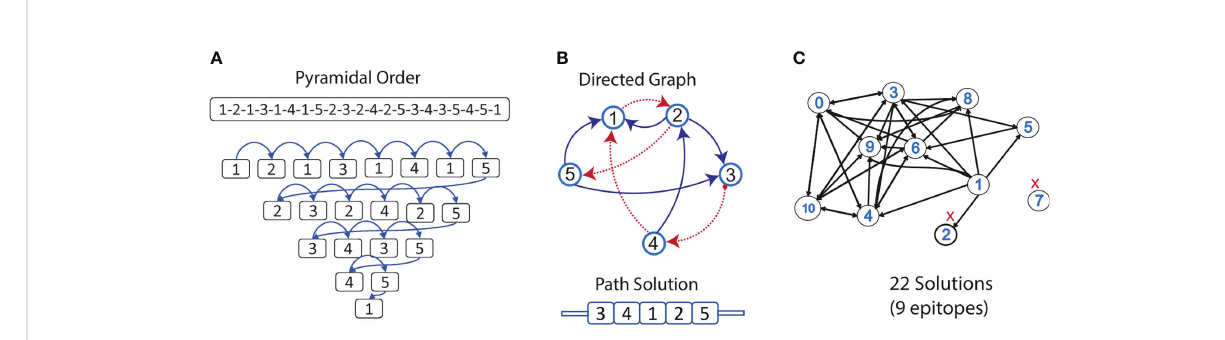
FIGURE 4 Selection of epitopes for the design of a multi-epitope construct. (A) An example of the pyramidal order for 5 epitopes, showing how they should be concatenated into a new protein, to evaluate the presence of neoepitopes in all the connections in just a single prediction step. (B) Allowed connections (without neoepitopes) are represented in the directed graph. The Hamiltonian path (in red) exempli fi es a solution containing all the nodes. (C) Graph representing the nested epitopes (nodes) and its allowed connections (edges), selected in this study for the construction of the multi-epitope construct. Epitopes discarded from the design are marked in